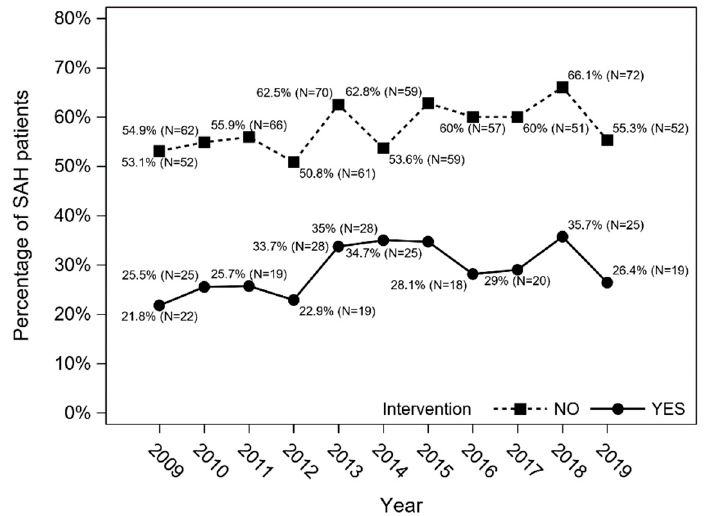
Figure 9. Combined mortality (in-hospital mortality and post-discharge 12-month mortality) in pa-